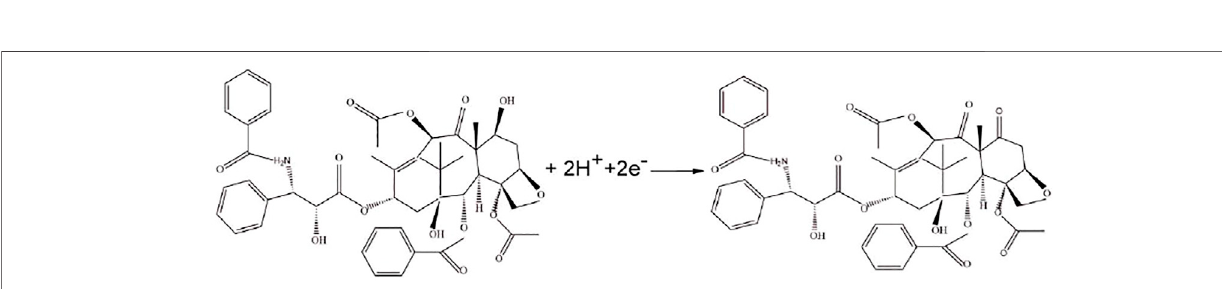
FIGURE 5 | Linear relationship with redox peak potential and logarithm of scan rate.